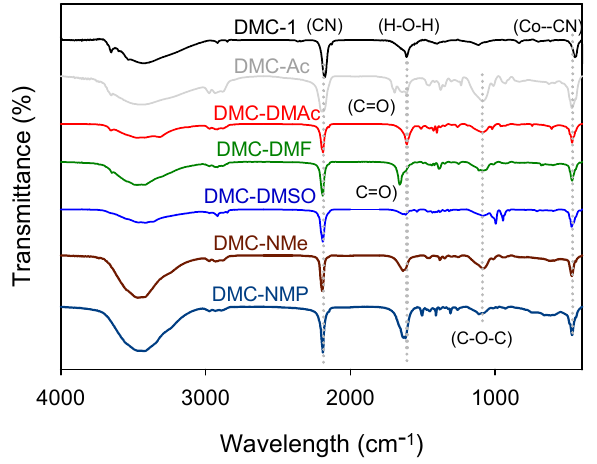
Figure 2. FTIR spectra of the DMC